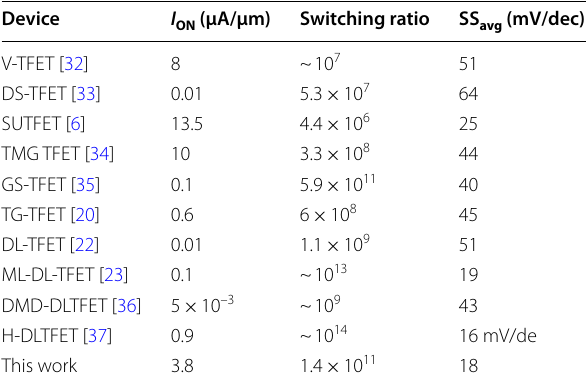
Table 2 Performance comparison of different TFETs with DF-TFET (at V